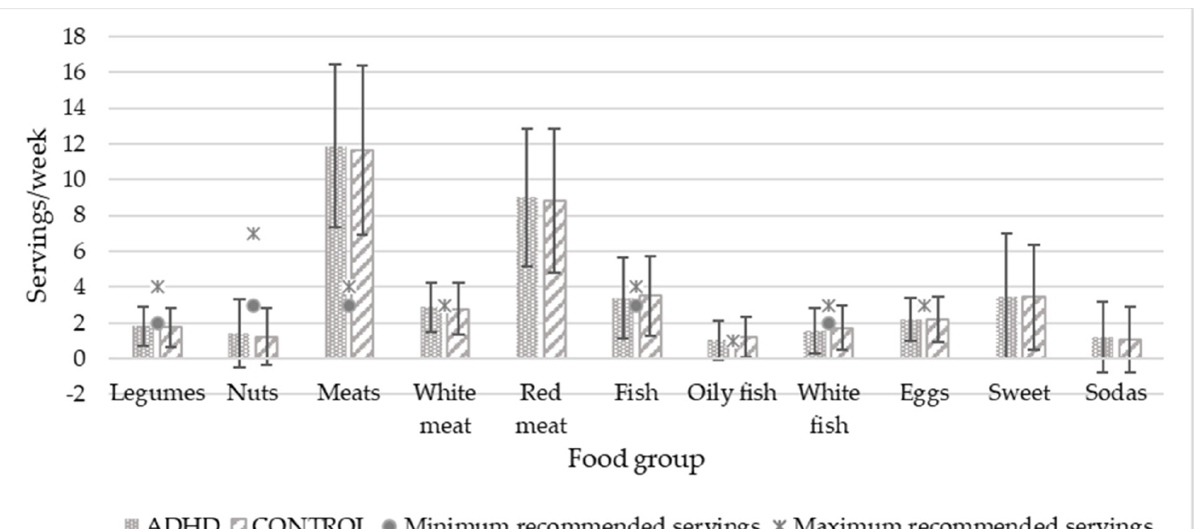
Figure 2. Weekly food consumption of study population in relation to recommended servings. Servings/day values are expressed by mean and standard deviation. No significant differences were shown. p < 0.05.